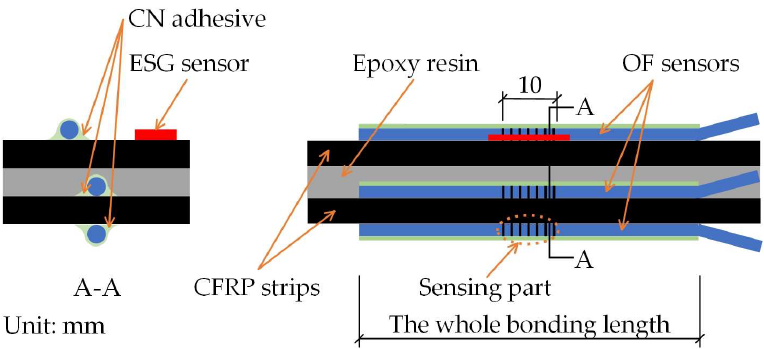
Figure 7. Illustration of the FBG-FRP segment of the C specimen.